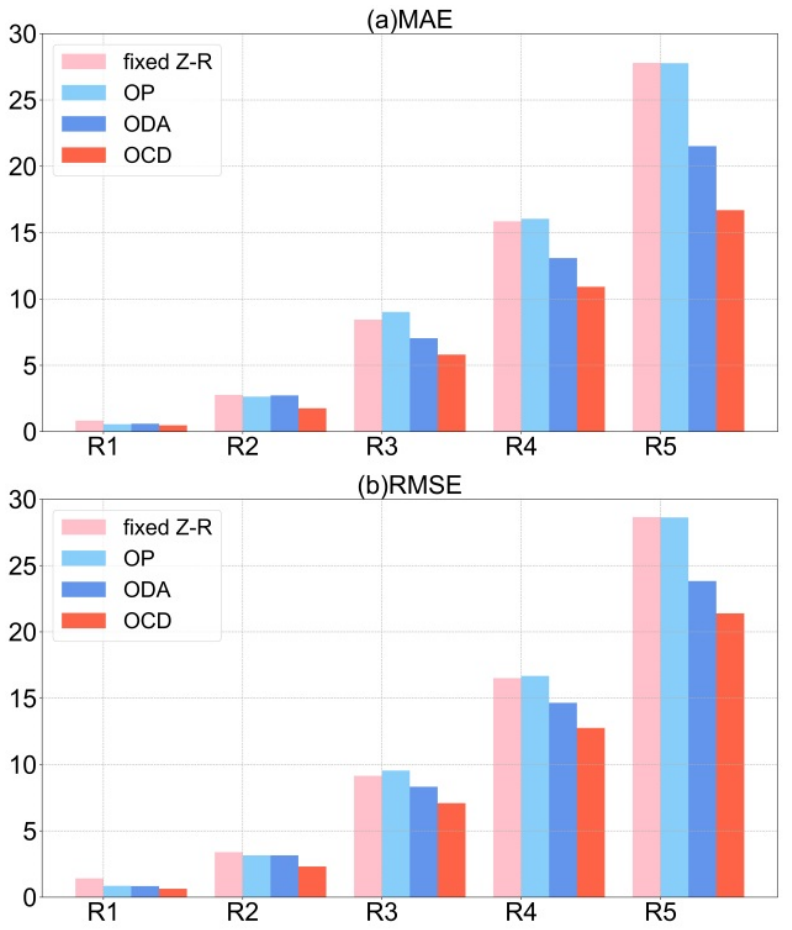
Figure 5. ( a ) MAE and ( b ) RMSE of fixed Z-R, OP, ODA, and OCD at different rain rates.